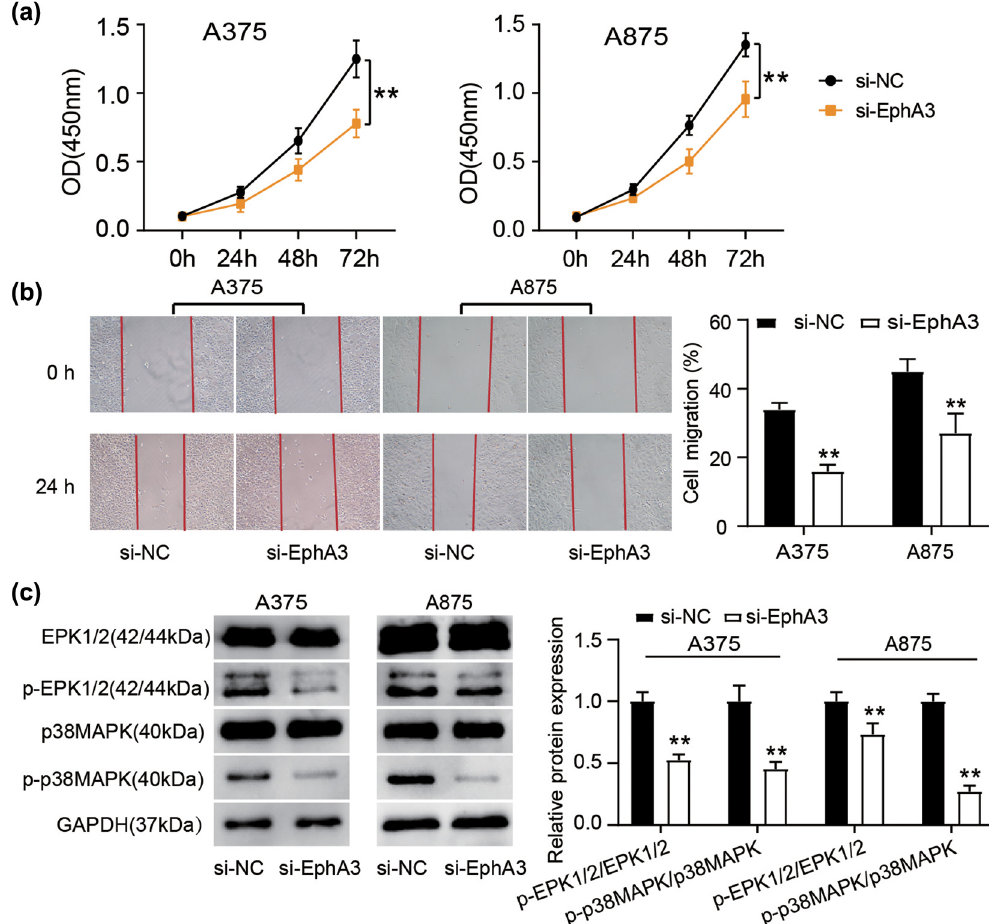
Figure 2: EphA3 silencing curbs the melanoma cell proliferation and migration in vitro by the impairment of MAPK/ERK signaling pathway. Si - EphA3 or si - NC was transfected into A375 and A875 cells. Forty - eight hours post - transfection. ( a ) Cell proliferation was assessed by CCK - 8 assays. ( b ) Scratch wound assays were adopted to determine the melanoma cell migration. ( c ) Western blot analysis of ERK1/2, p - ERK1/2, p38MAPK, and p - p38MAPK in these transfected cells. ** P < 0.01 vs si - NC.